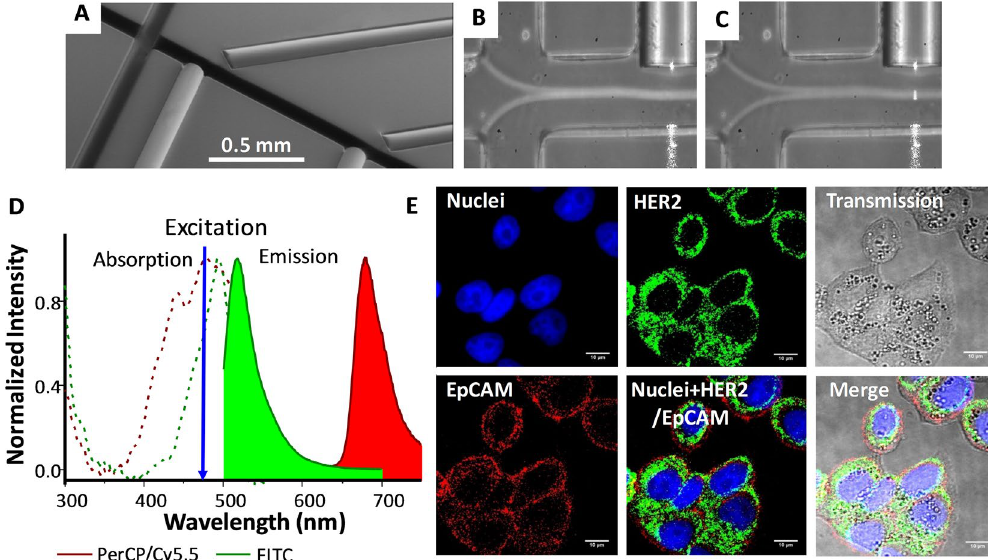
Figure 1. Optofluidic Chip. ( A ) SEM image of the optofluidic chip. ( B and C ) Confinement of the sample at the central region of the channel. A blue light path ( C ) is visible only when a cell intersects the pumping beam. Absorption and emission properties of the dyes used to label the antibodies and their performance on the cell membrane. ( D ) Absorption and emission profiles of anti-HER2-FITC (green) and anti-EpCAM-PerCP/Cy5.5 (red) antibodies. ( E ) Laser scanning confocal microscopy images of AU-565 cells stained with anti-HER2-FITC conjugated (green) and anti-EpCAM-PerCP/Cy5.5 conjugated (red) antibodies. Nuclei were stained with DAPI (blue). Scale bar 10 μ